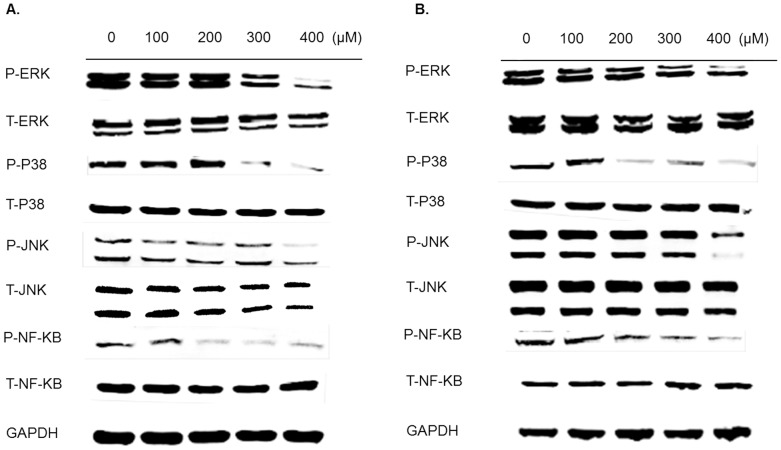
The expression of MAPK and NF-κB proteins in vitro.The expression of MAPK and NF-κB signaling decreased as I3C concentration increased in 5-8F(A) and CNE2(B). The data are presented as the mean± SEM.